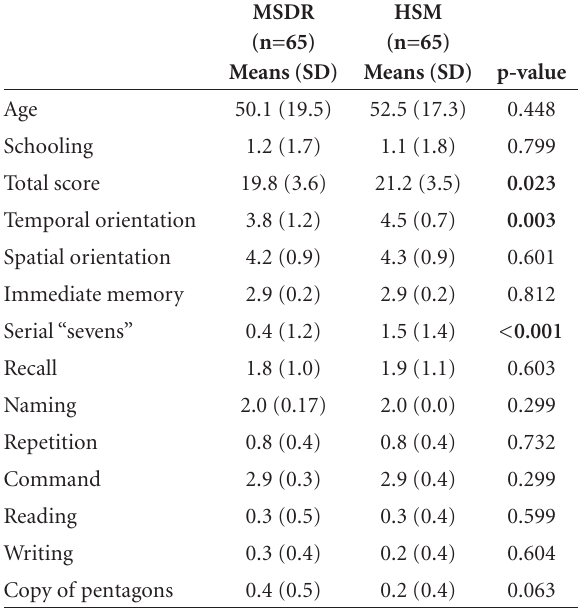
Table 1. Sample comparisons regarding age, schooling, and MMSE scores.